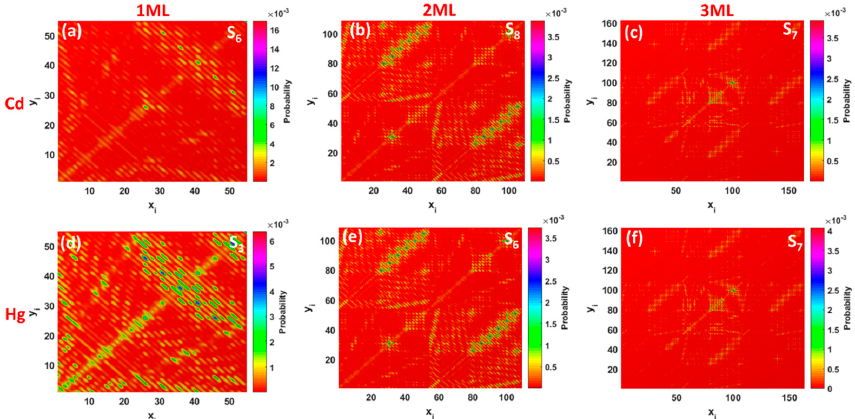
Figure 6. Two-dimensional representations of the simulated transition density matrix corresponding to the lowest excited states in thickness-varying GQDs after interaction with elemental heavy metals: ( a – c ) Cd and ( d – f ) Hg on monolayer (1ML), bilayer (2ML), and trilayer (3ML) GQDs, respectively. Colour bars are given on the right.